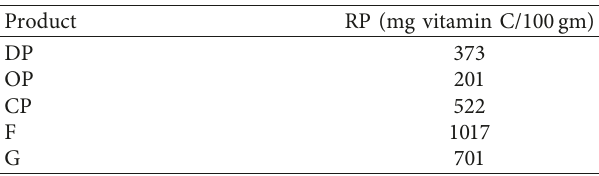
Table 2: Reducing power (RP) of F and G candy samples and their basic components.